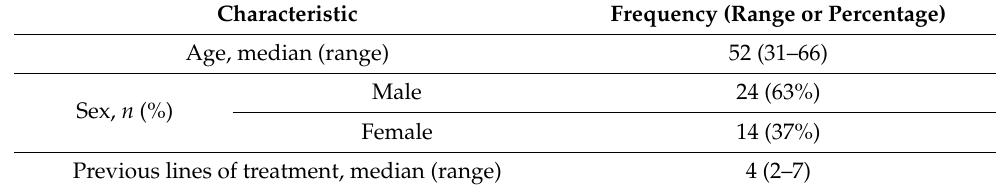
Table 1. Patient and transplant-related characteristics ( n =